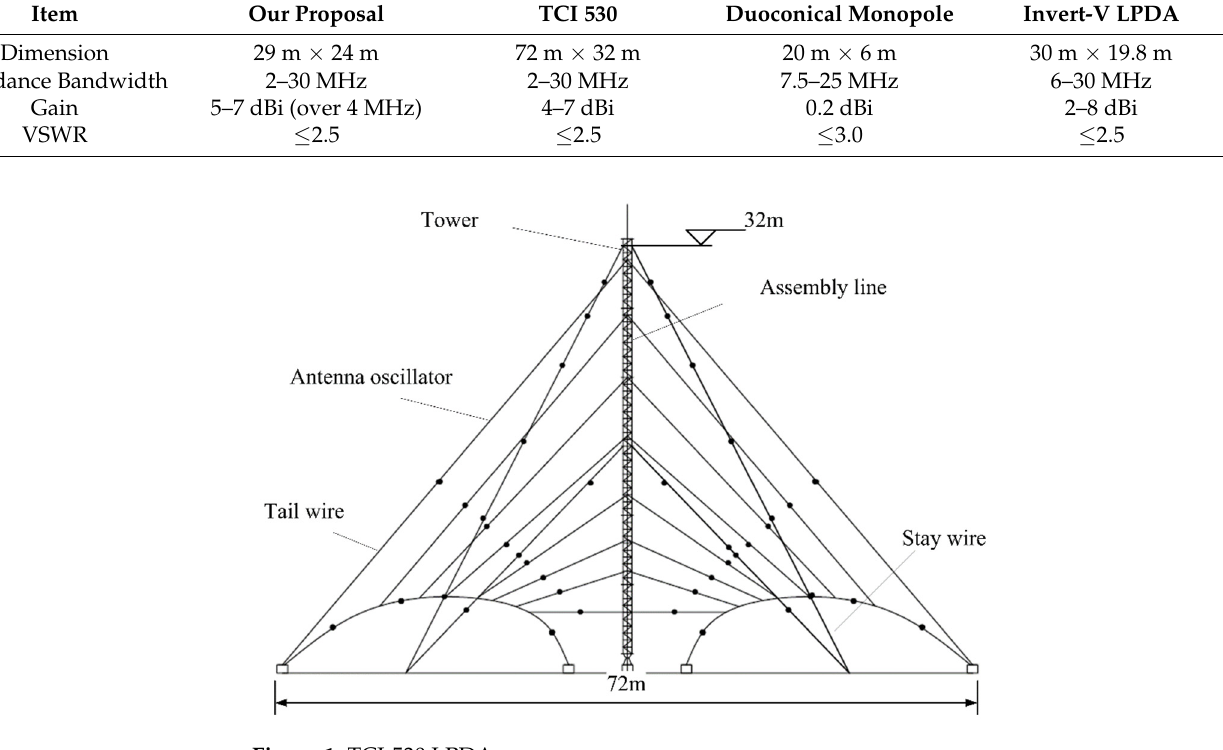
Figure 1. TCI-530 LPDA.